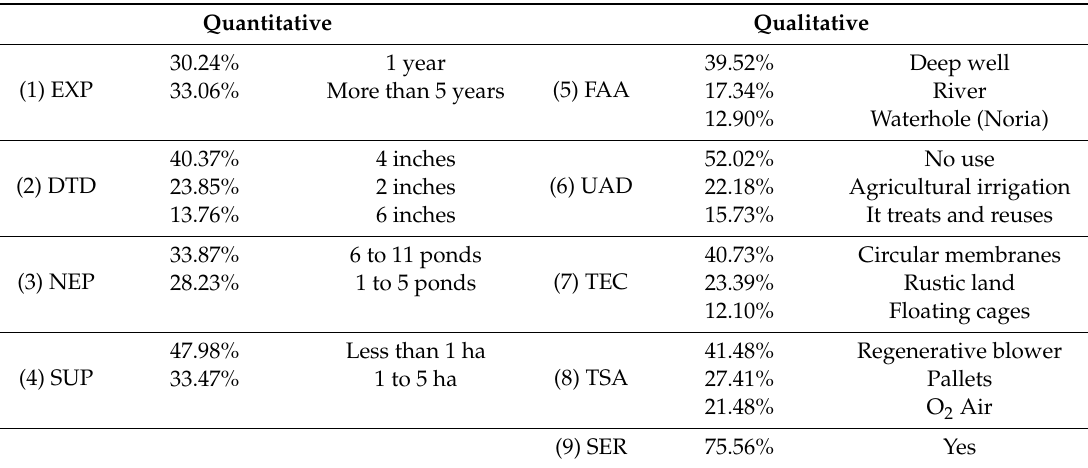
Table 2. Main results of the Mexican UPA. Technological category and system management (2019). Quantitative Qualitative